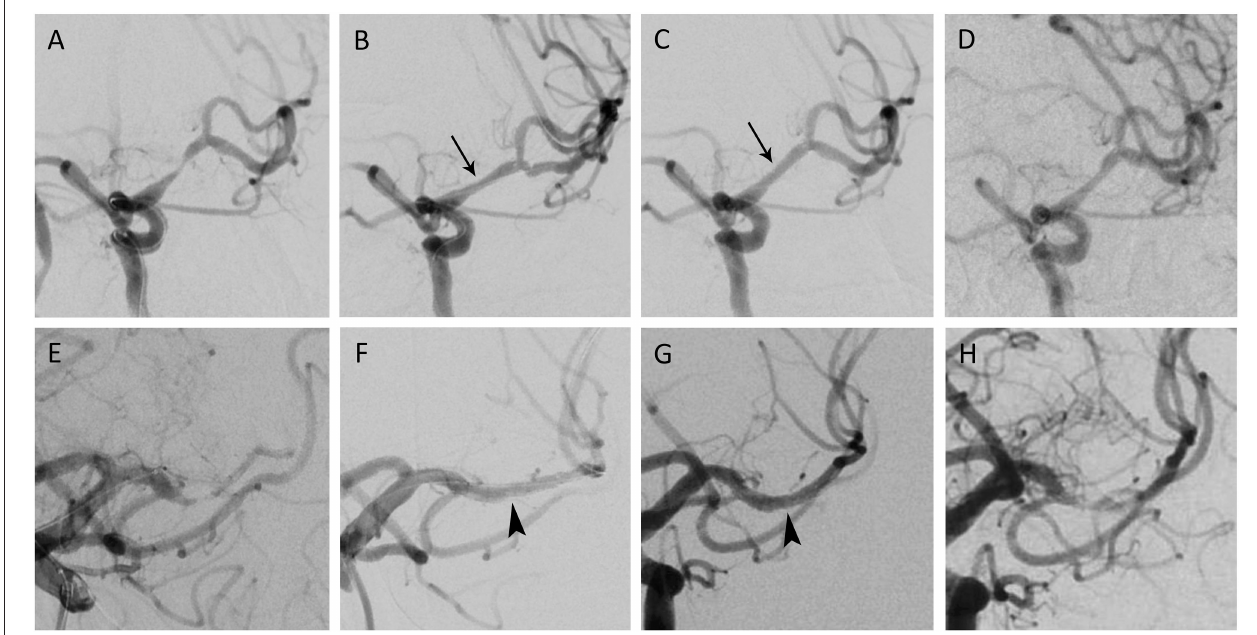
FIGURE 2 | Percutaneous transluminal angioplasty and wingspan stenting of middle cerebral artery (MCA) stenosis. (A) A patient in their 60s presented with right hemiparesis due to cerebral infarction. The angiography showed left MCA stenosis by 79.7%, with a total of 5.5mm in length. (B) After pre-dilation and wingspan stenting, the angiogram demonstrated 41.1% residual stenosis. (C) Post dilation decreased the residual stenosis to 16% (black arrow). (D) The 1-year angiographic follow-up showed stenosis by 32.1%. (E) Another patient in their 70s came for slurred speech after ischemic stroke. Angiography depicted 81.6% stenosis in the left MCA M1 segment; the lesion was 4.6mm and eccentric. (F) After the wingspan stenting, the immediate residual stenosis was 14.6%. (G) Stent apposition improved after post stenting dilation (arrowhead), with residual stenosis downsized to 10.7%. (H) After 1 year, 77.7% of multifocal in-stent restenosis was observed. The patient was asymptomatic, with a stationary Modified Rankin